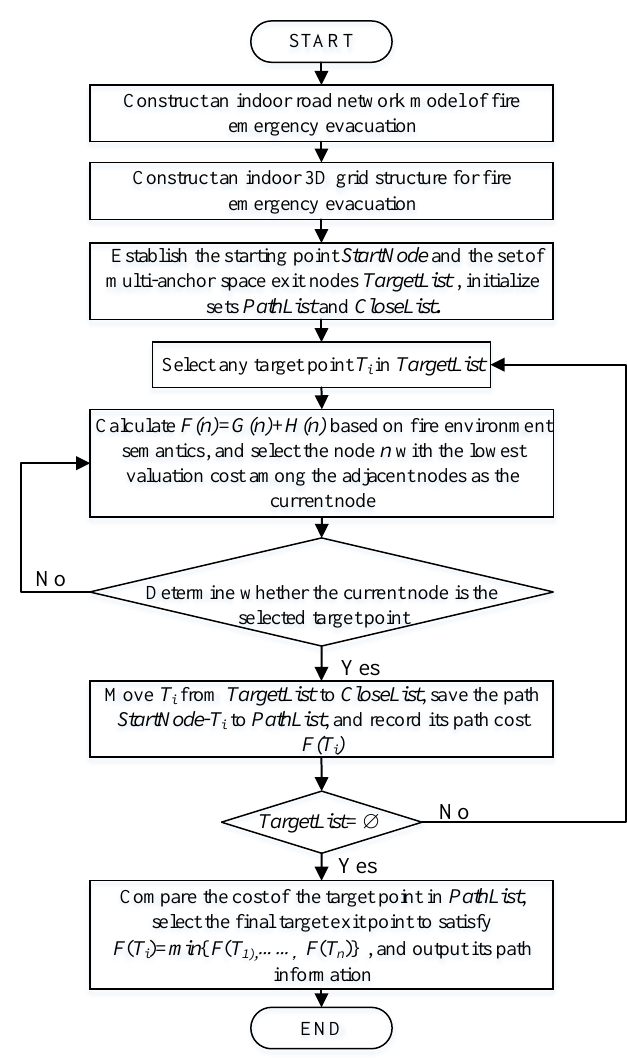
Figure 4. Flow chart of indoor routing algorithm with multiple semantic constraints.